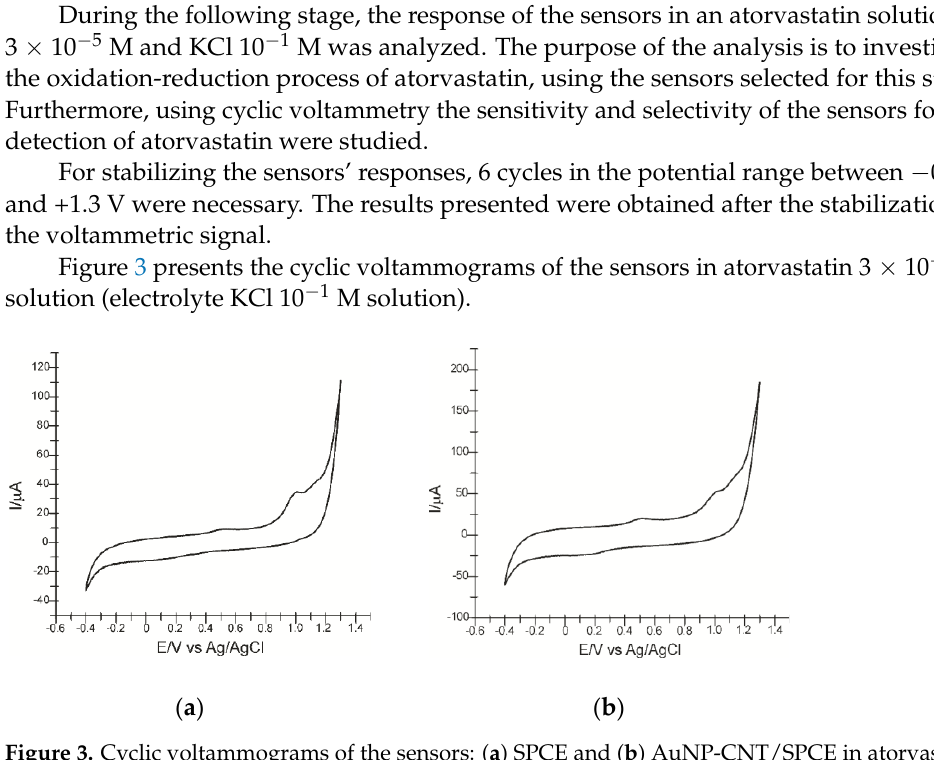
Figure 3. Cyclic voltammograms of the sensors: ( a ) SPCE and ( b ) AuNP-CNT/SPCE in atorvastatin 3 × 10 − 5 M solution. Scan rate 0.1 V/s.